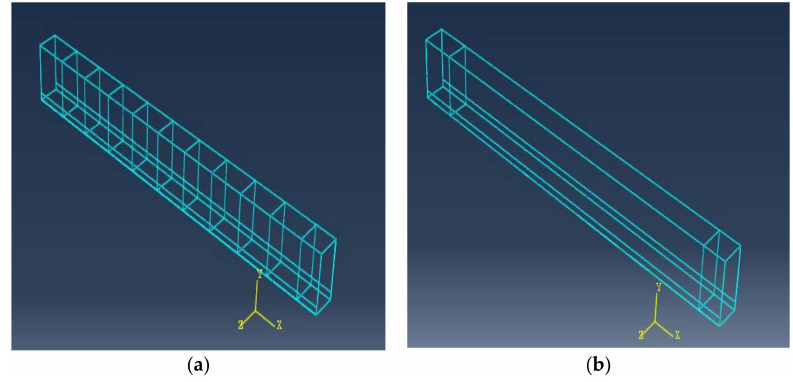
Figure 10. Beam reinforcement meshes: ( a ) with stirrups; ( b ) without